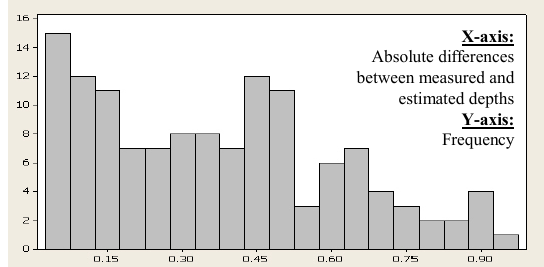
Figure 7. The histogramme of absolute differences between measured and estimated depths (area C). 67% of the differences are under